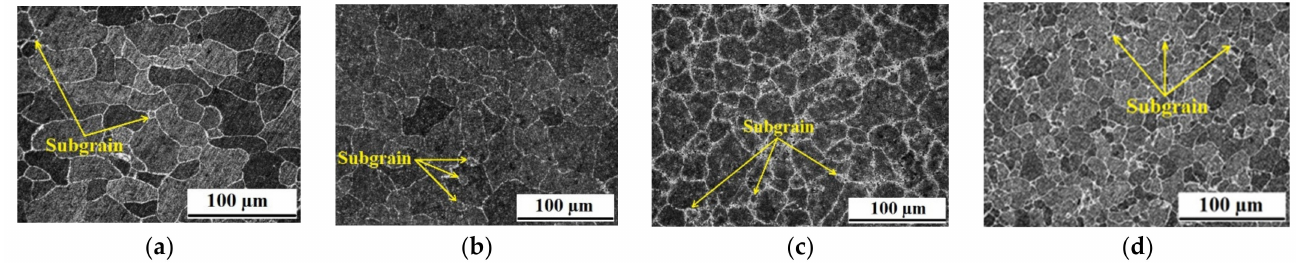
Figure 4. Microstructure of Al5083 alloy of ( a ) annealed and ECAP after ( b ) 1st pass, ( c ) 2nd pass, and ( d ) 3rd pass.